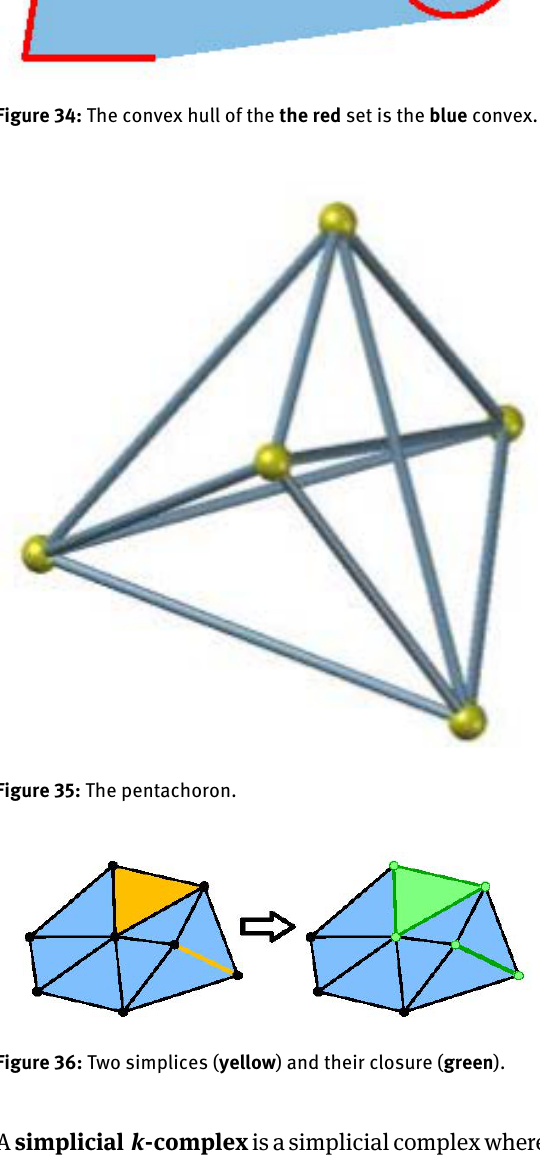
A simplicial k -complex isasimplicialcomplexwherethe largest dimension of any simplex equals k .